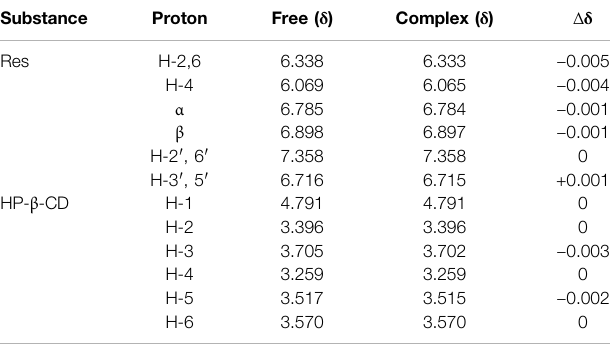
TABLE 1 | Variation of the 1 H NMR chemical shifts (ppm) of Res and HP- β -CD protons in free and complex states determined in DMSO-d6. Substance